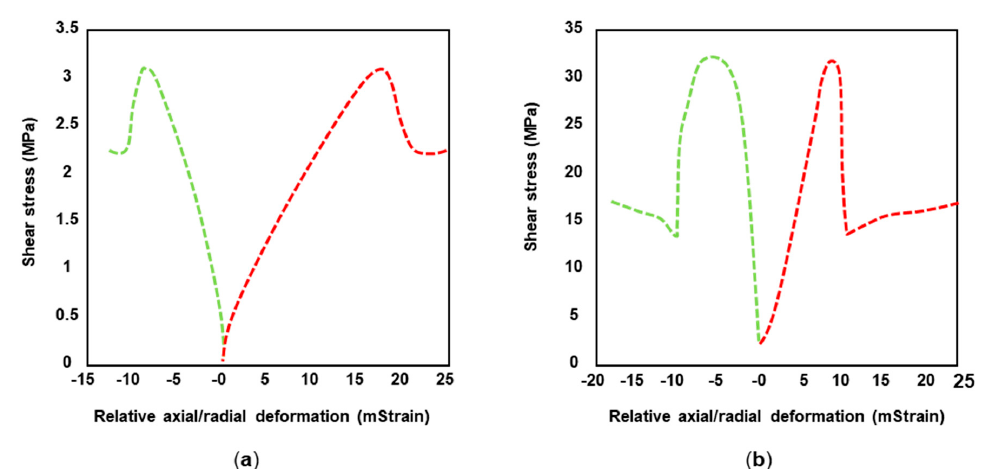
Figure 5. ( a ) CIU on shale specimen and ( b ) CID on sandstone specimen.